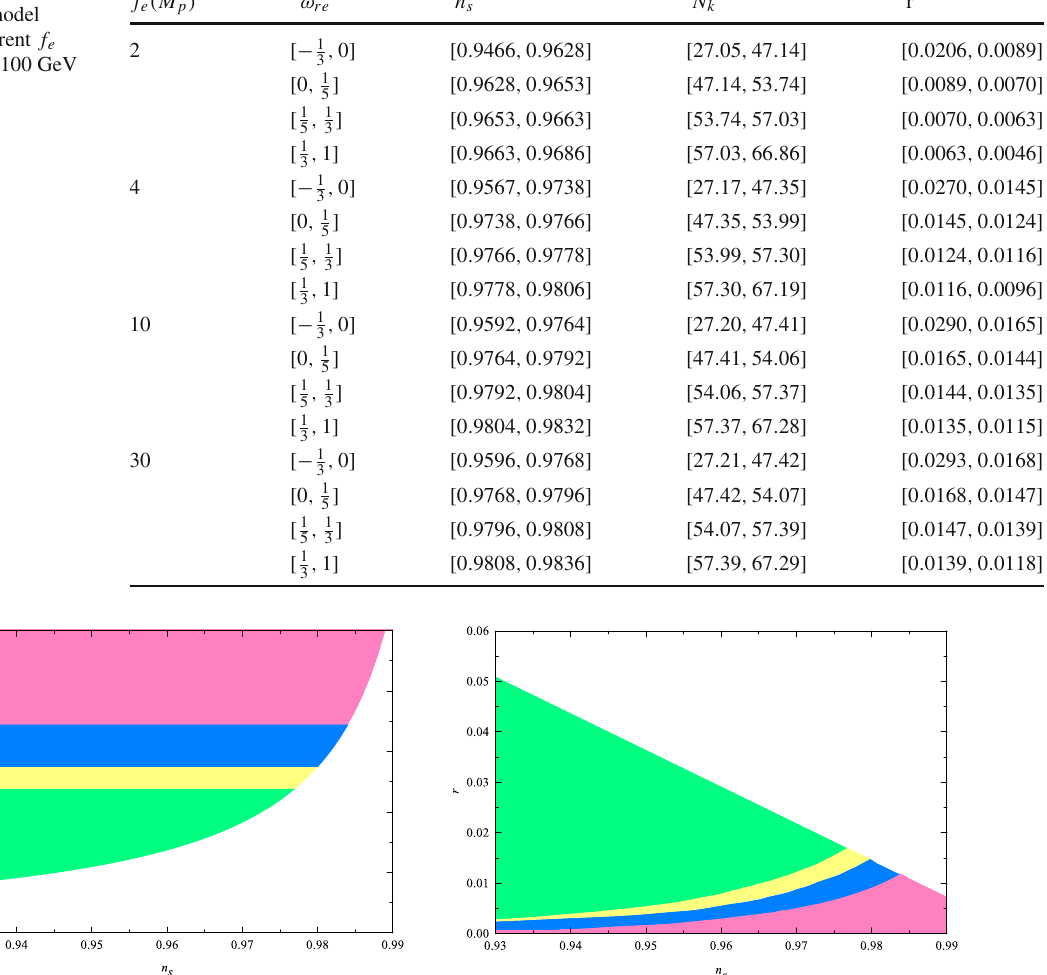
Fig. 6 N k vs n s and r vs n s under the ENI model, where f e < 30 M p . The legend of the shadow area refer to Fig. 4 2018 error range under the constraints of 1